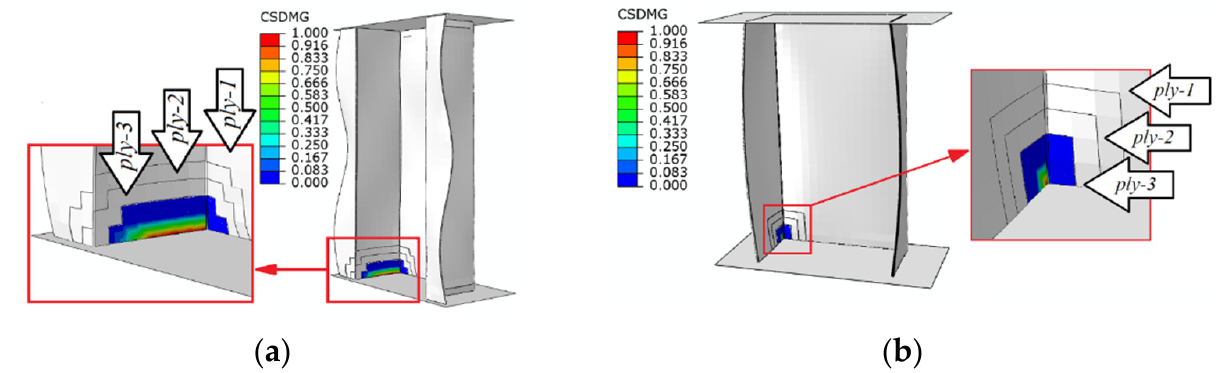
( b ) Figure 6. Damage initiation (Hashin criterion—PFA model): ( a ) top-hat column, ( b ) channel column. Based on the tests, it was observed that the damage initiation occurred due to the matrix tensile damage of the composite material (HSNMTCRT). The damage initiation was registered at loads: 14,032 N—top-hat specimen and 4222 N—channel specimen.